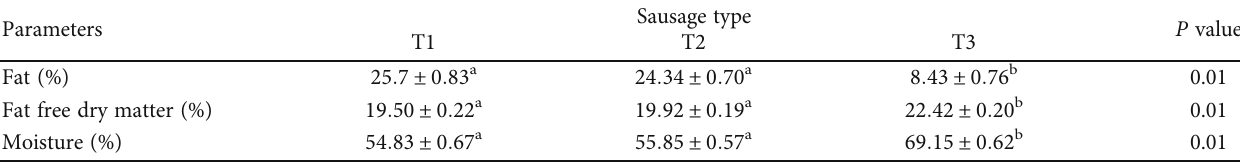
Table 1: Proximate composition of the raw beef sausage forti fi ed with edible animal wastes. Parameters